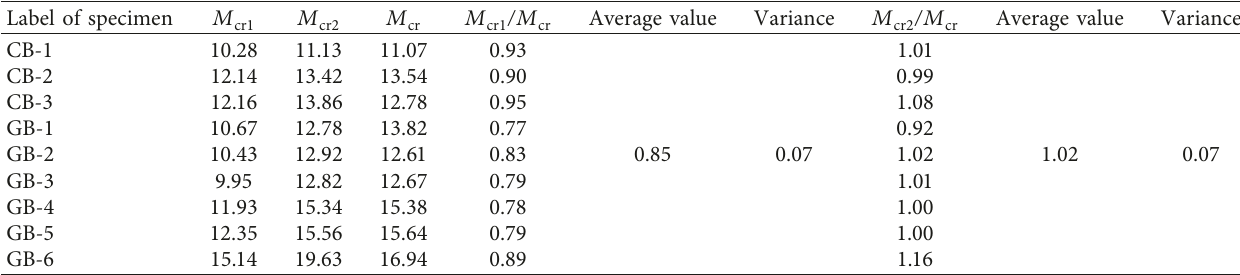
Table 12: Calculation of the cracking moment.